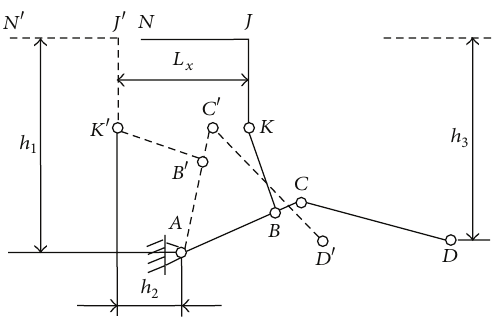
Figure 6: The schematic diagram of the clamping mechanism.